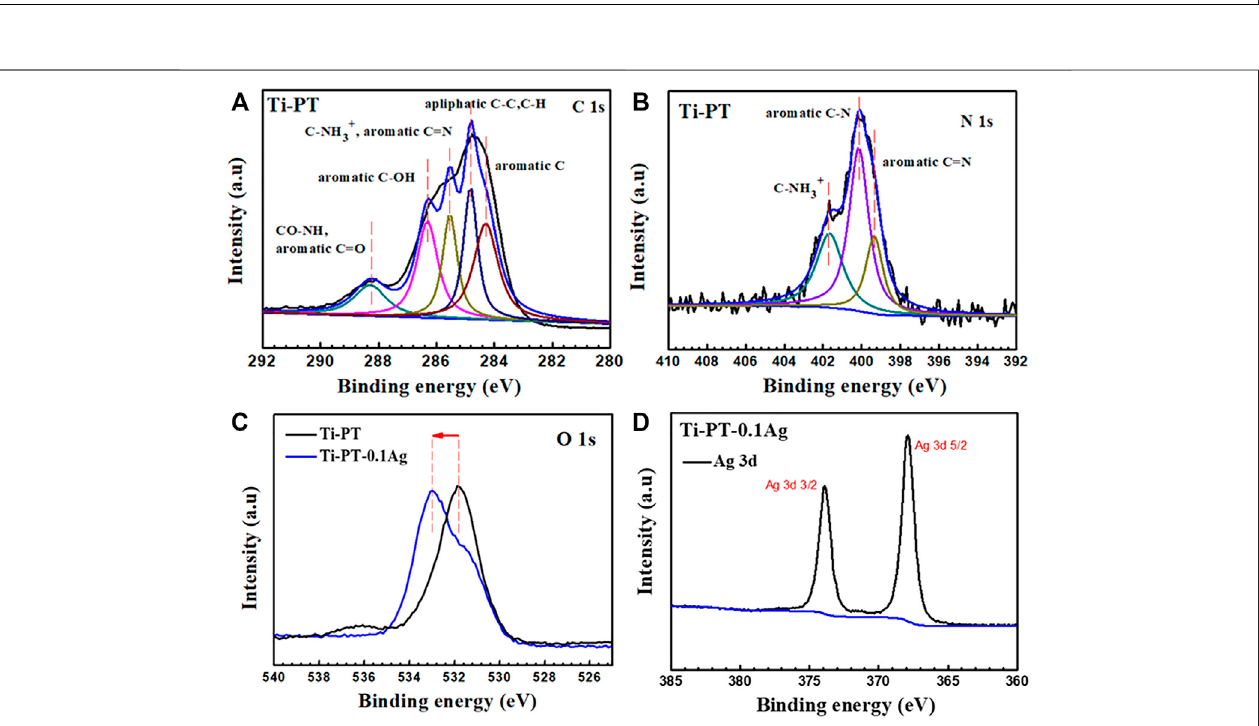
FIGURE 5 | High-resolution XPS spectra and fi tting results of C 1s (A) , N 1s (B) , O 1s (C) , and Ag 3d (D) on Ti-PT and Ti-PT-0.1Ag.